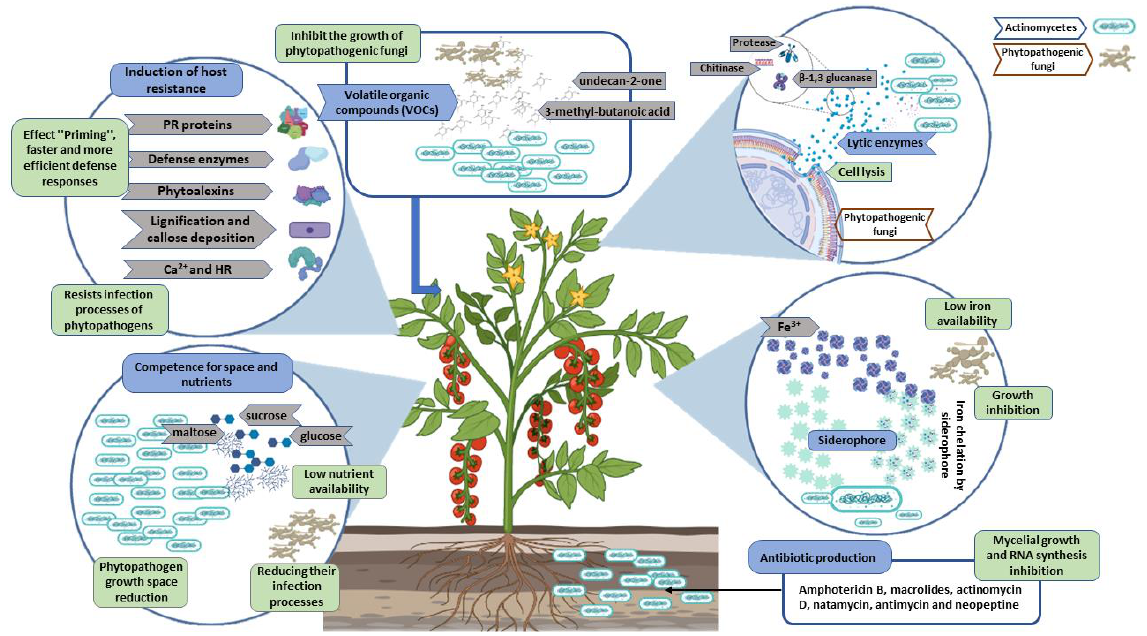
Figure 1. Main actinomycete antagonistic mechanisms to phytopathogenic